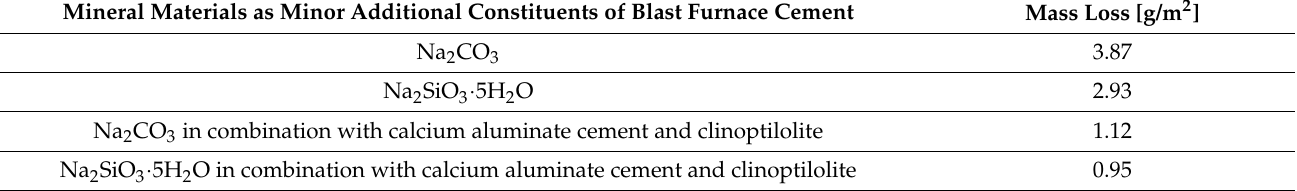
Figure 15. Steel rebars embedded in the plasticized concretes based on blast furnace cement containing Na 2 CO 3 ( a ) or Na 2 SiO 3 · 5H 2 O ( b ) in combination with calcium aluminate cement and clinoptilolite as minor additional constituents and mixed with sea water after 180 days of hardening (Magnification: × 4). Table 4. The state of the steel rebars embedded in the plasticized blast furnace cement concretes mixed with sea